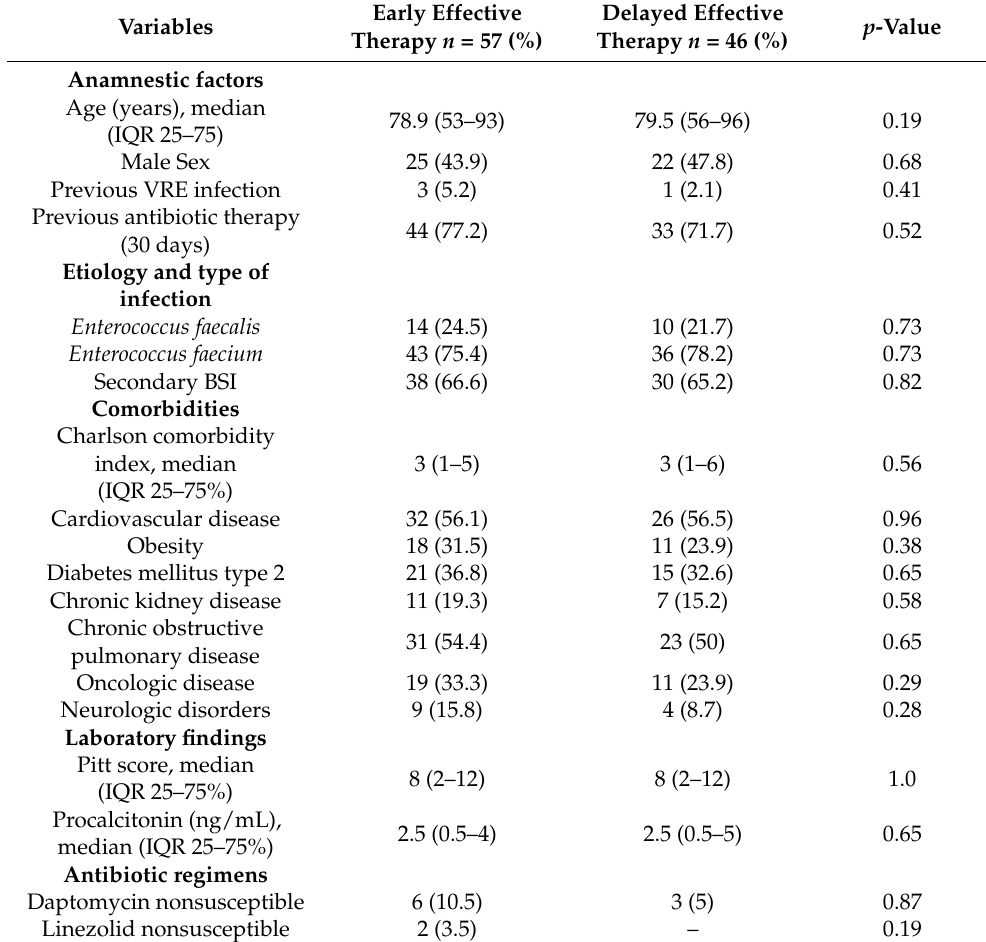
Table 1. Comparison between patients treated with early effective or delayed effective